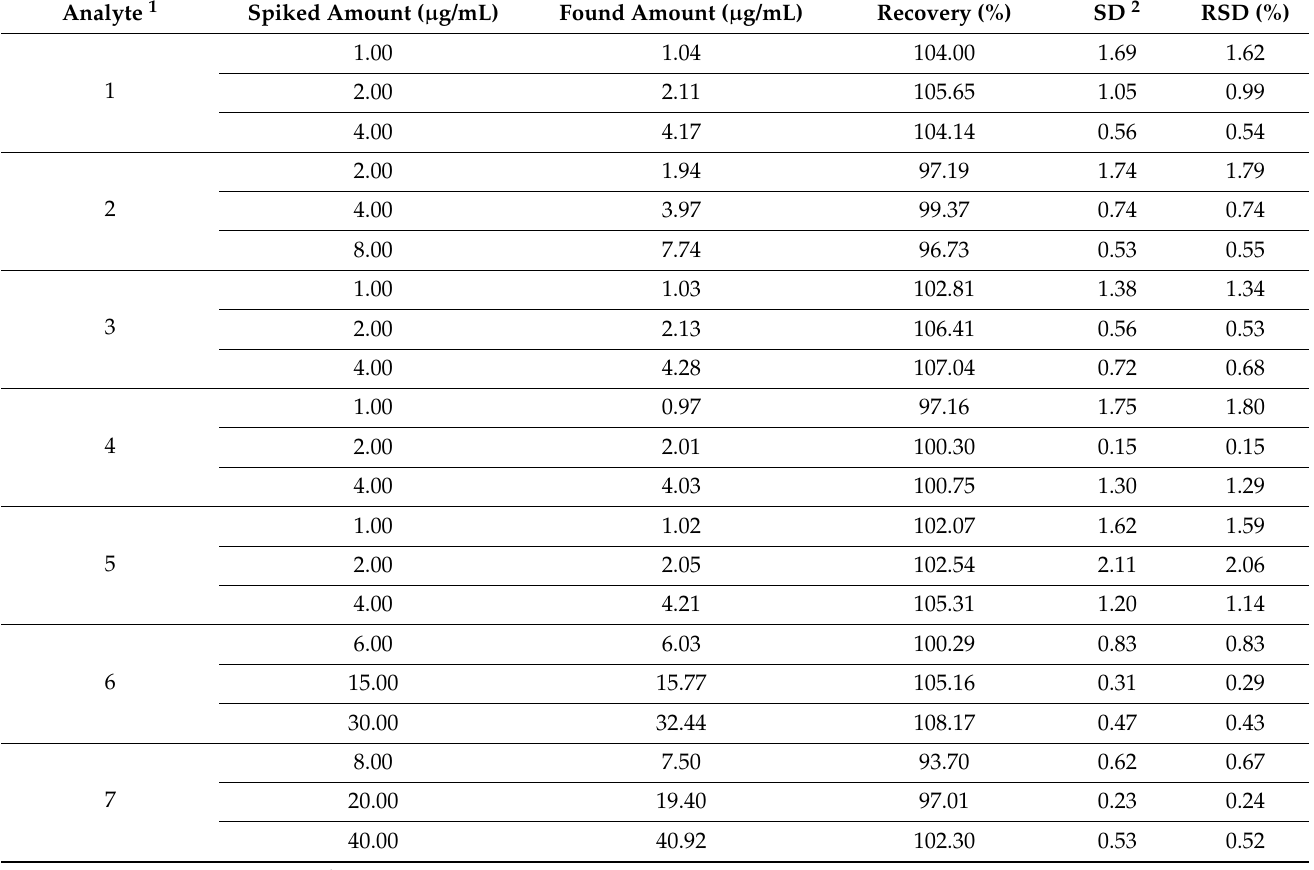
Table 3. Recovery (%) of the seven target components for the developed HPLC method.